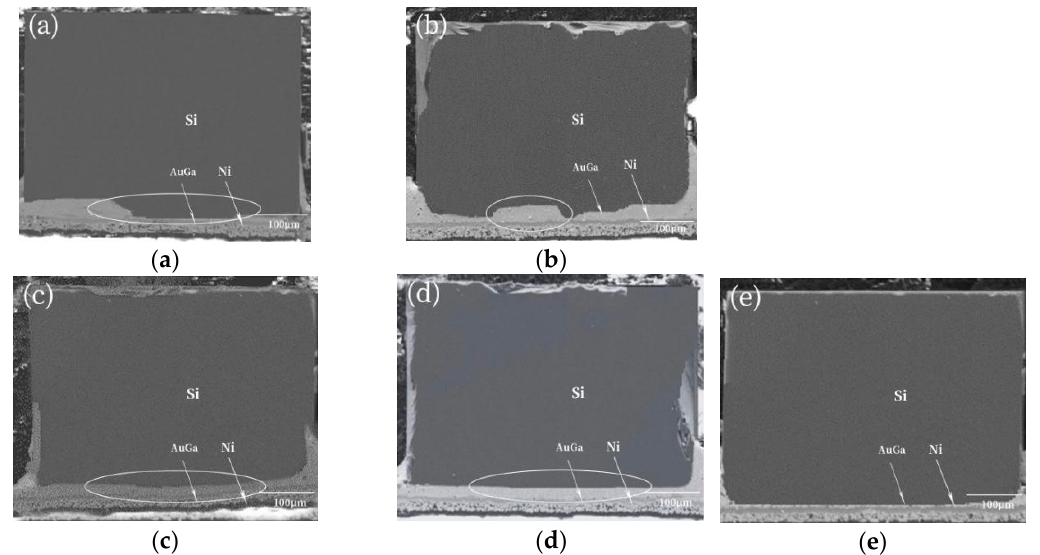
Figure 3. Cross-section morphologies of the samples at different soldering temperatures: 360 °C ( a ), 380 °C ( b ), 400 °C ( c ), 420 °C ( d ), and 440 °C ( e ).